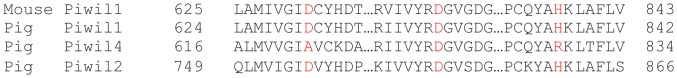
Sequence alignment showing the catalytic triad (DDH motif) of mouse Piwil1 and porcine Piwi family proteins.Catalytic aminoacids are shown in blue.